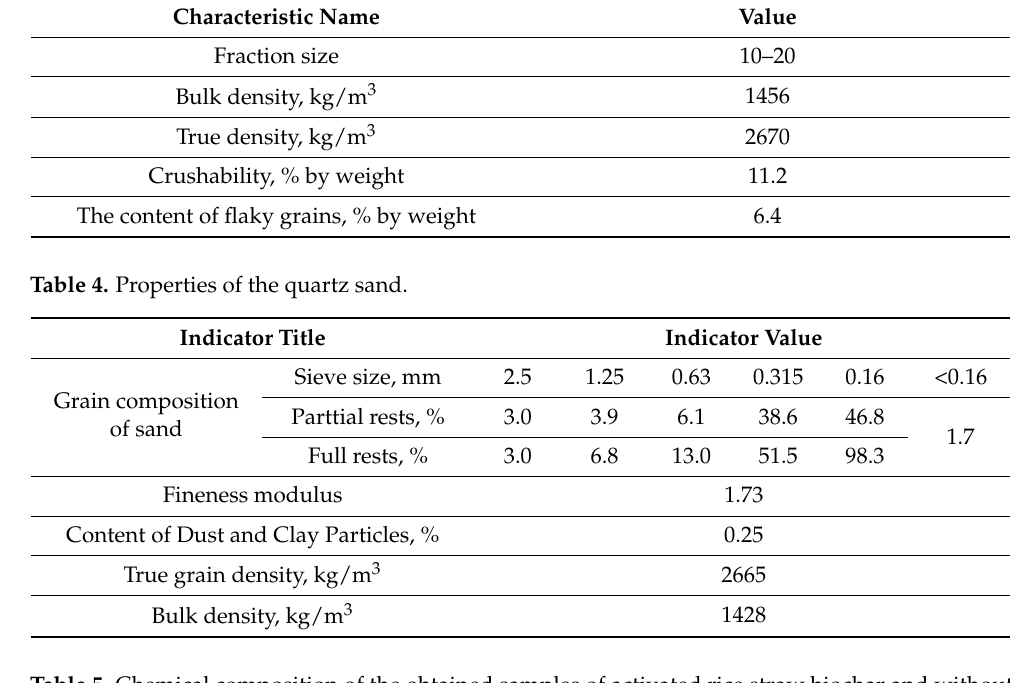
Table 3. Properties of the granite crushed stone.